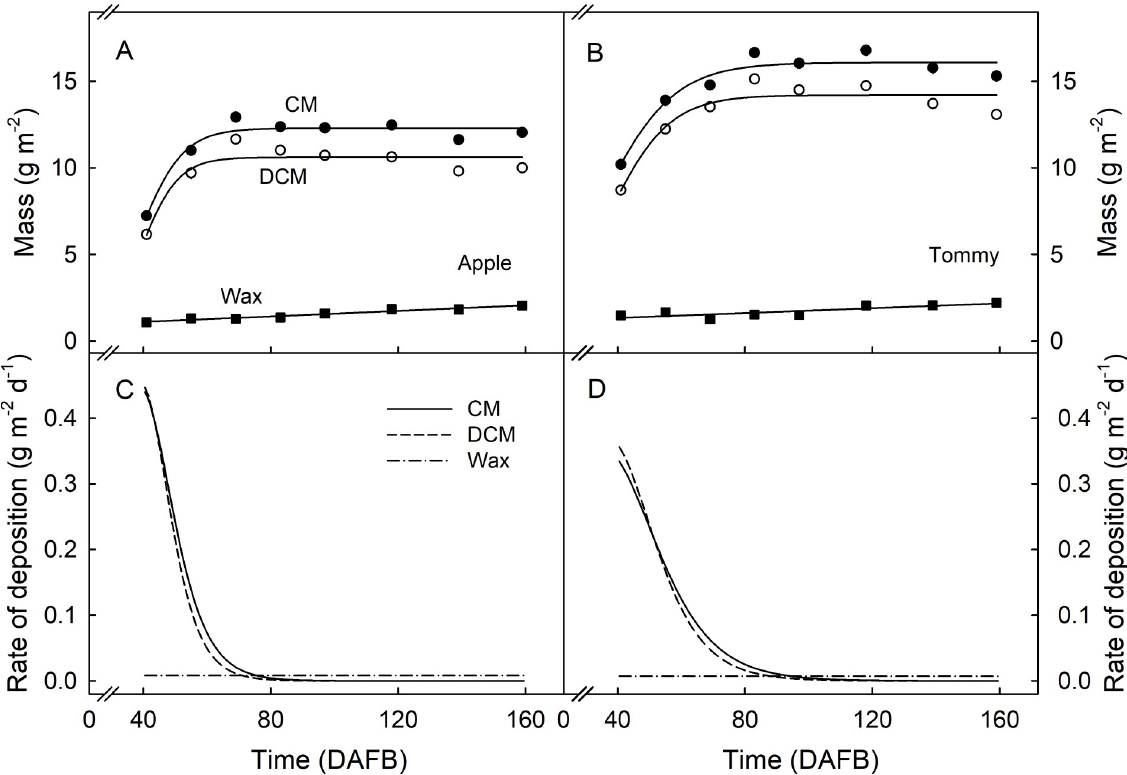
Fig 6. Developmental time course of change in mass of cuticular membrane (CM), dewaxed CM (DCM) and wax of ‘Apple’ (A) and ‘Tommy Atkins’ (B) mango. Rates of deposition of CM, DCM, and wax of ‘Apple’ (C) and ‘Tommy Atkins’ (D) mango. The rates of deposition were calculated as the first derivative of a regression equation fitted through a plot of CM, DCM or wax mass vs. time. The x-axis scale is in days after full bloom (DAFB). Data in Fig 6A and 6B represent means ± SE. The number of replicates was 33–35.